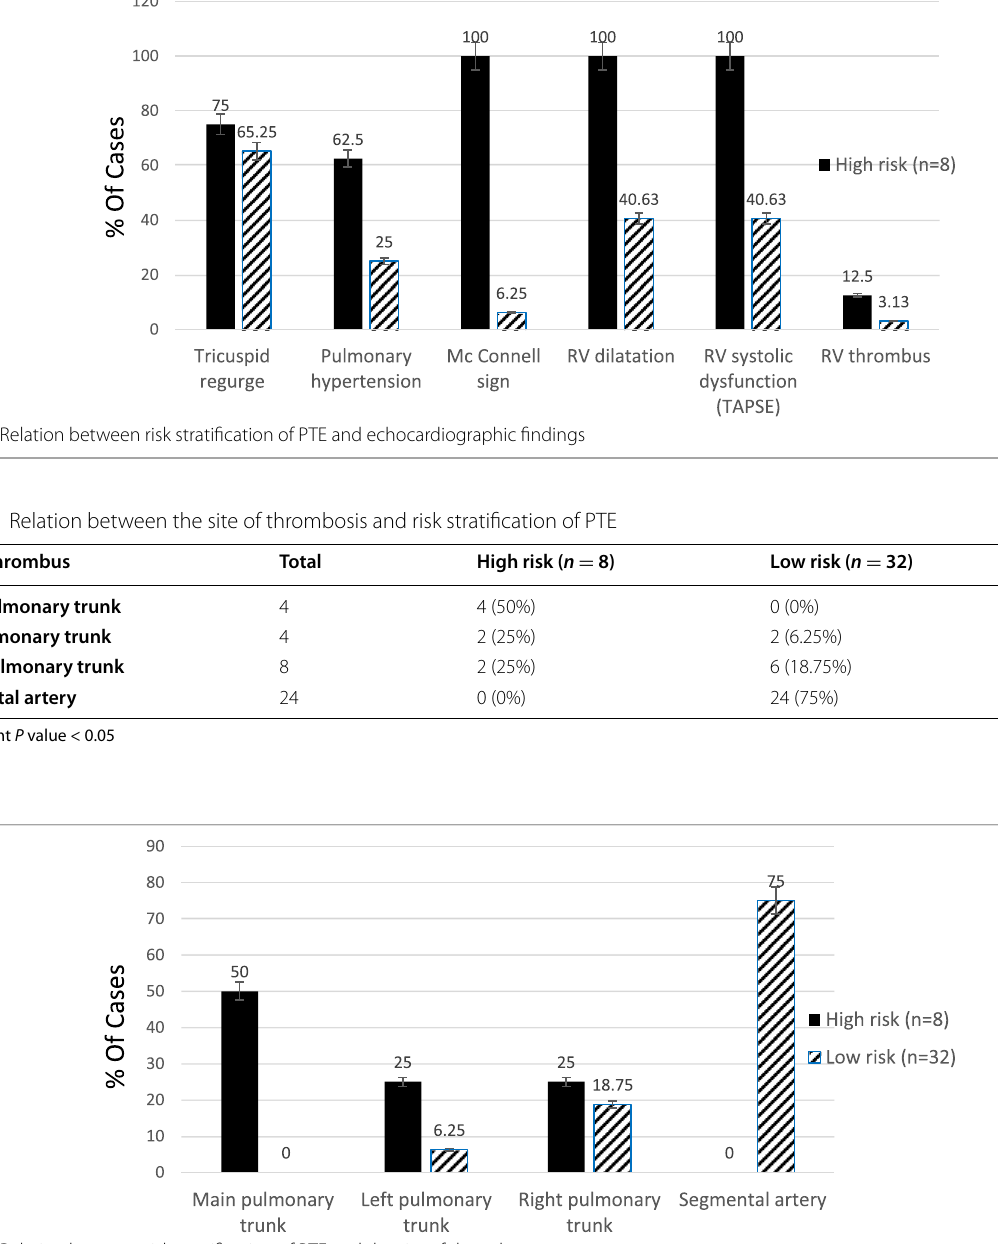
Fig. 2 Relation between risk stratification of PTE and the site of